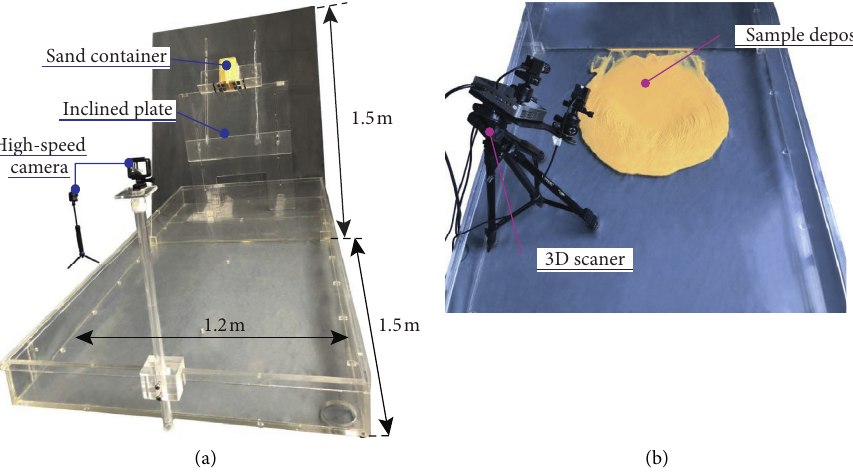
Figure 1: Flowslides experimental research design: (a) structural of the experimental device; (b) 3D scanner for acquisition of deposit data.